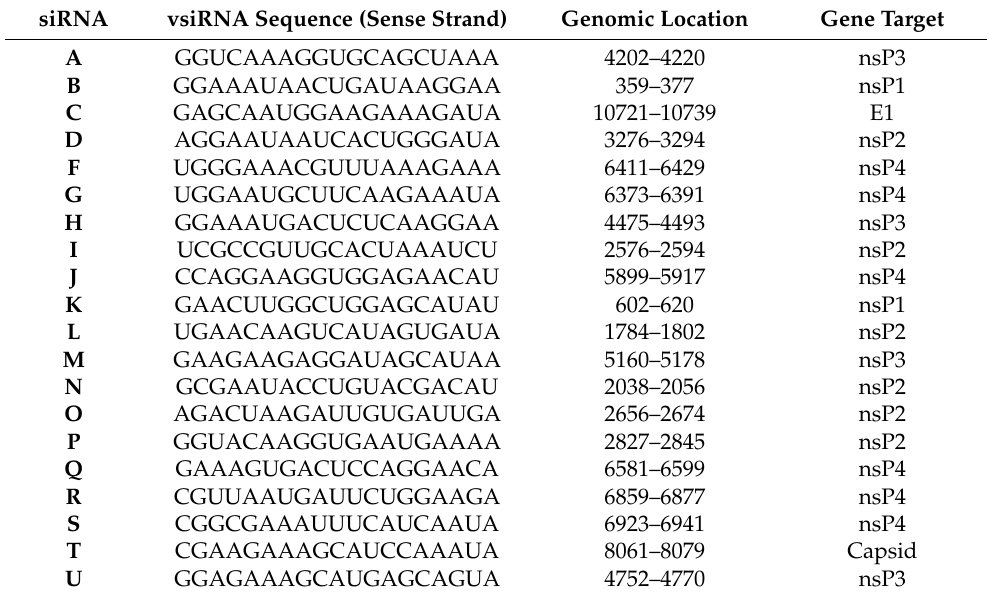
Table 1. vsiRNA sequence and genomic location of